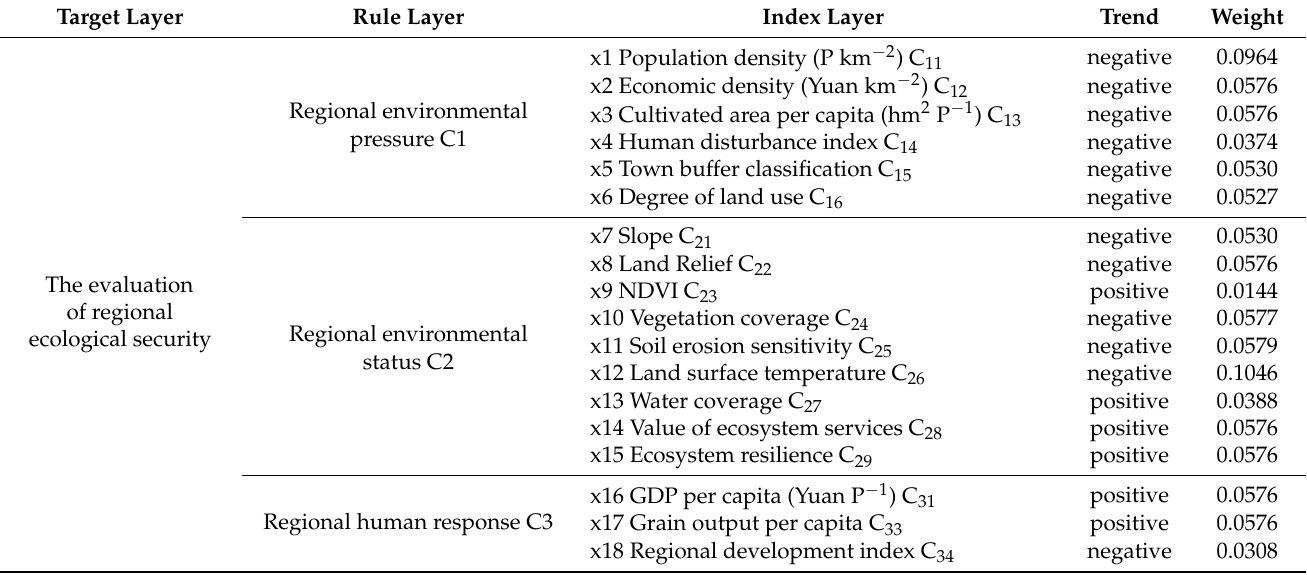
Table 1. The evaluation system of land ecological security (LES) in Yan’an. LES represents land ecological security. 18 indexes of natural-socio-economic-ecological systems are divided into environmental pressure, environmental status, and human response based on the structure of the PSR model to evaluate LES. Target